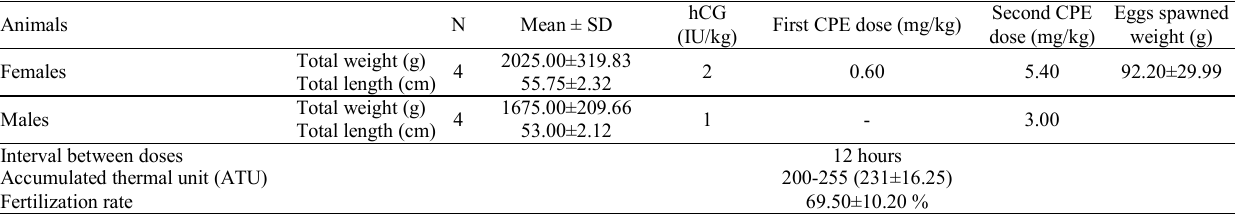
Table 1. Steindachneridion parahybae reproduction at CESP Fish Farm in December/2007 and in January/2008. Data are presented as the mean ± standard